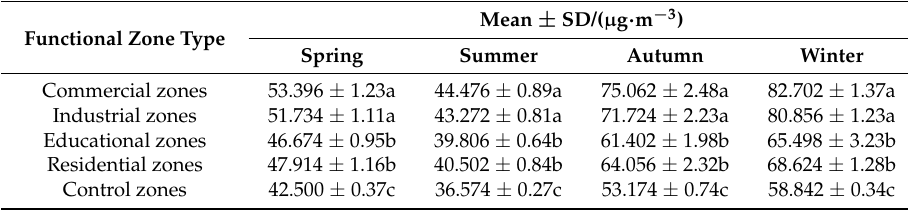
Table 4. PM 2.5 concentrations in the functional zones in four seasons.